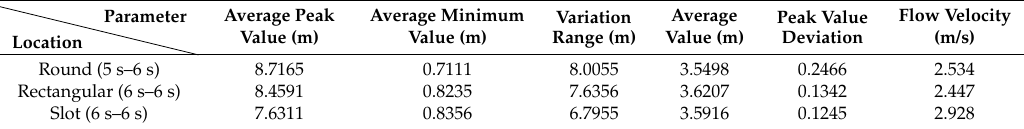
Table 13. Flushing results when different shape nozzles are set in the middle of the pipe.